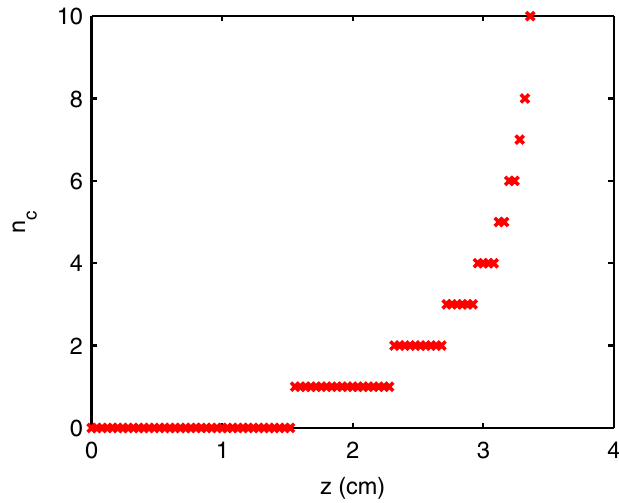
FIG. 8. (Color) Number of ion-bunch collisions as a function of the ionization coordinate. Ions originating beyond the point z ¼ 3 : 4 cm do not reach the